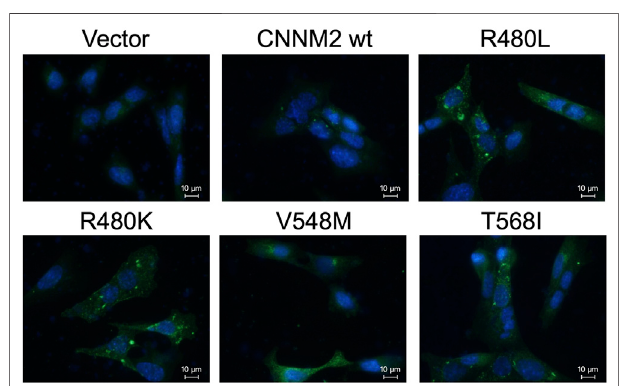
FIGURE 4 | Immunocytochemistry microscopy. Images of transiently transfected murine distal convoluted tubular cells (mDCT) with wild-type and mutant constructs. Cells were immunostained with antibodies against the CNNM2 (in green). Nuclei were counterstained with DAPI (in blue). This demonstratesthattheexpressionsofmutantCNNM2arehigherthanthoseof wild-type CNNM2.